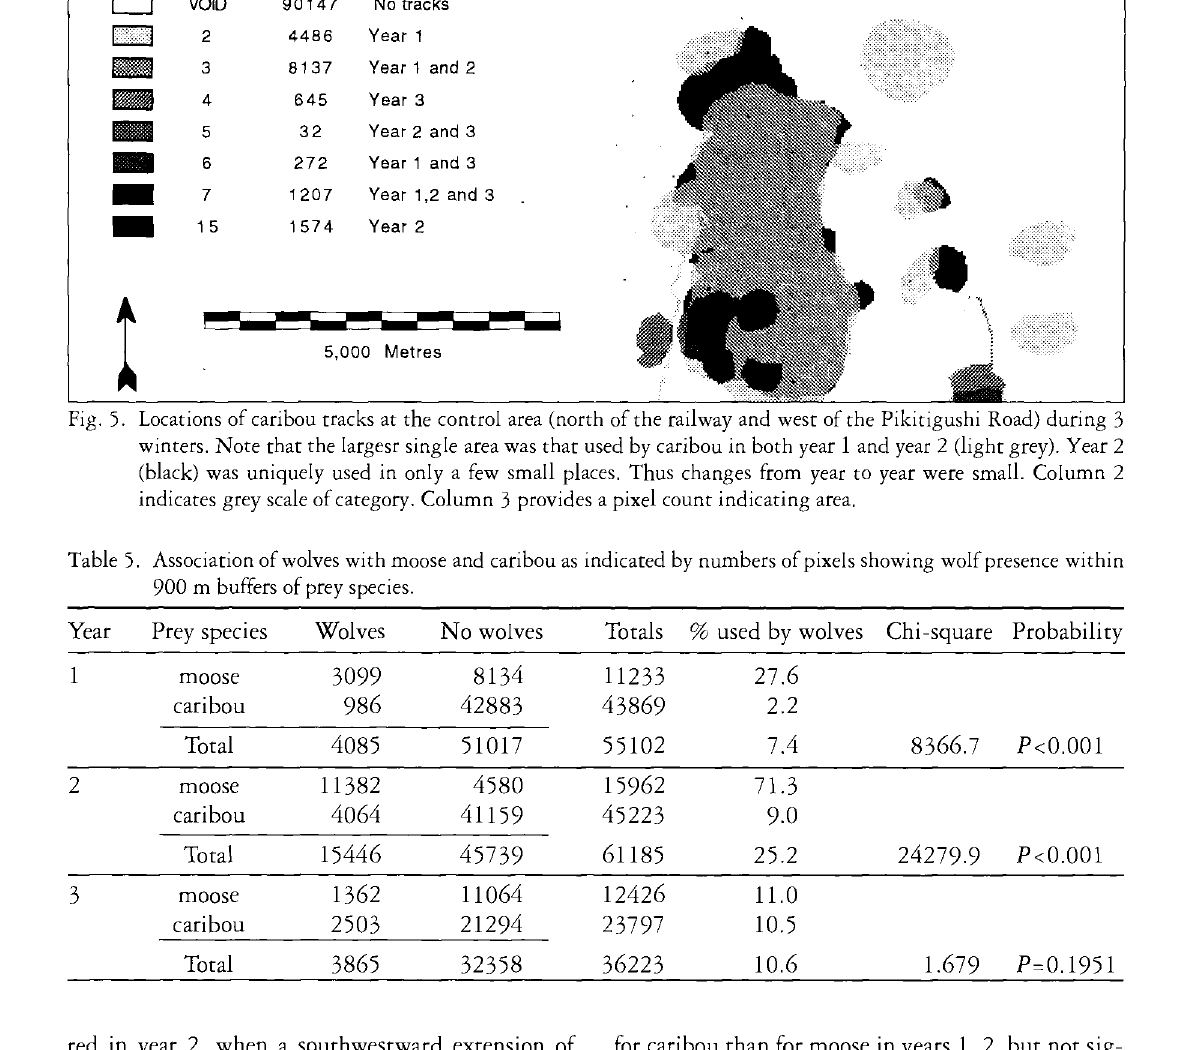
Fig. 5. Locations of caribou tracks at the control area (north of the railway and west of the Pikitigushi Road) during 3 winters. Note that the largesr single area was that used by caribou in both year 1 and year 2 (light grey). Year 2 (black) was uniquely used in only a few small places. Thus changes from year to year were small. Column 2 indicates grey scale of category. Column 3 provides a pixel count indicating area. Table 5. Association of wolves with moose and caribou as indicated by numbers of pixels showing wolf presence within 900 m buffers of prey